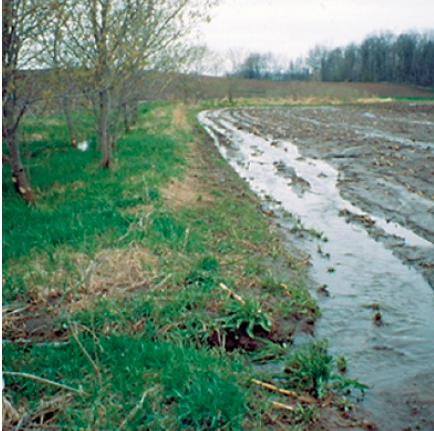
Figure 5. Storm runoff. Image courtesy of the U.S. Geological Survey, Wisconsin Water Science Center.